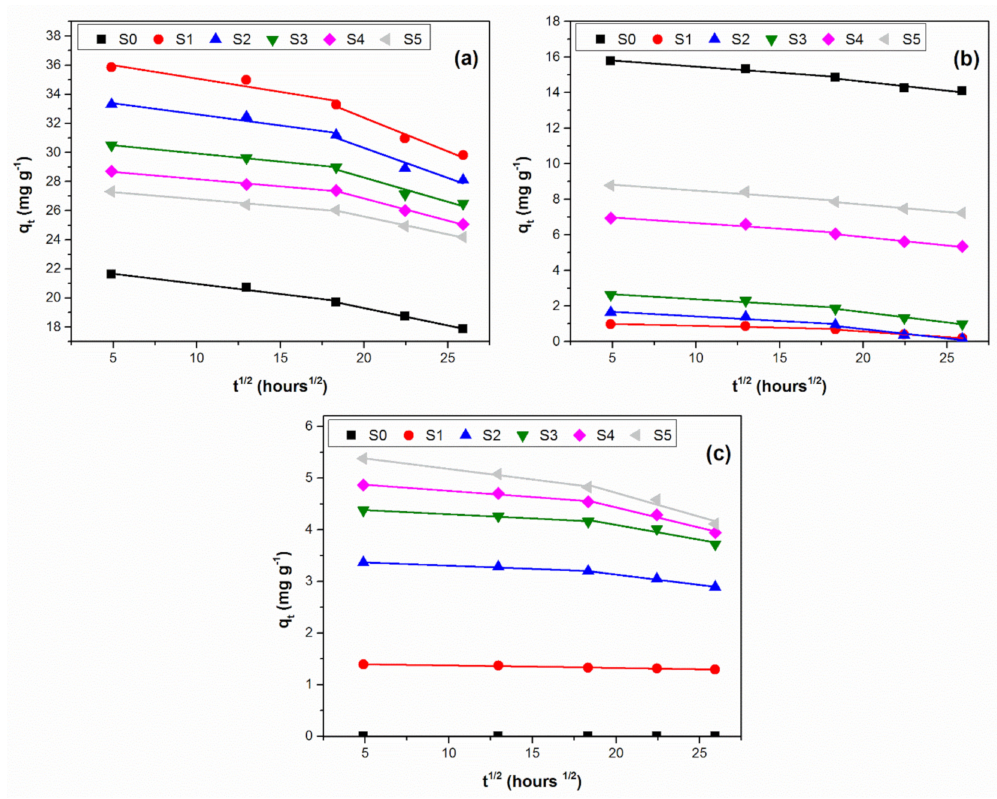
Figure 4. Intraparticle diffusion model plot for the investigated glasses: ( a ) phosphorous ions; ( b ) potassium ions; ( c ) man- ganese